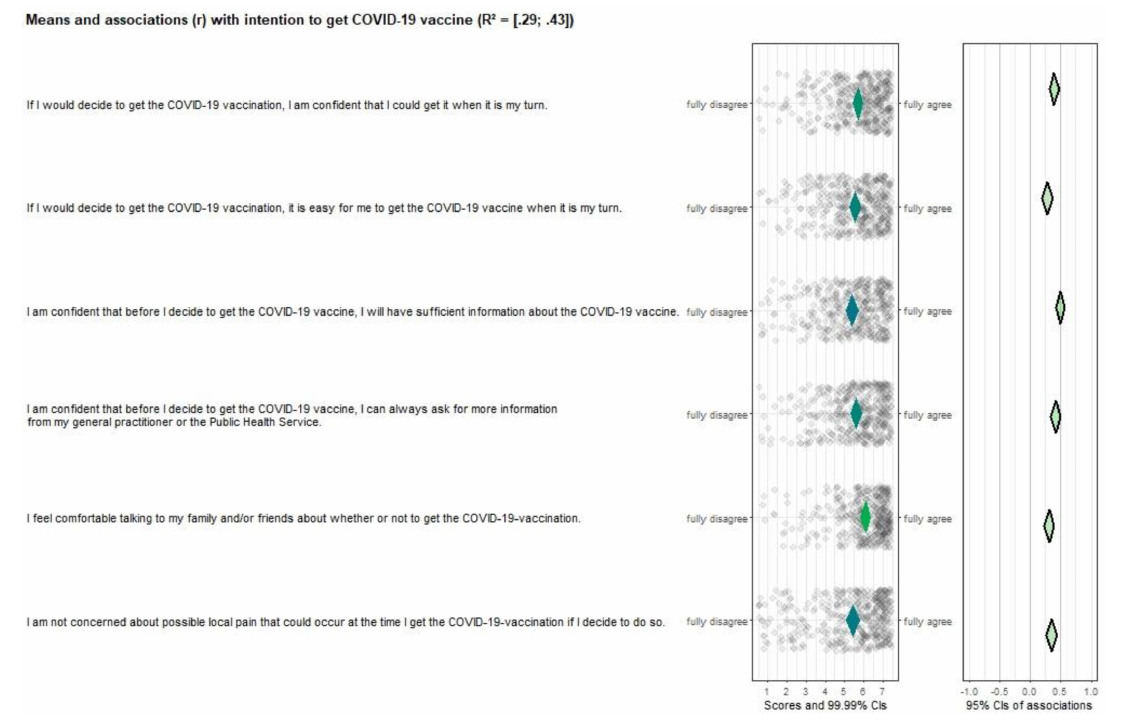
Figure 5. CIBER plot of self-efficacy visualizing means and association with intention to get the COVID-19